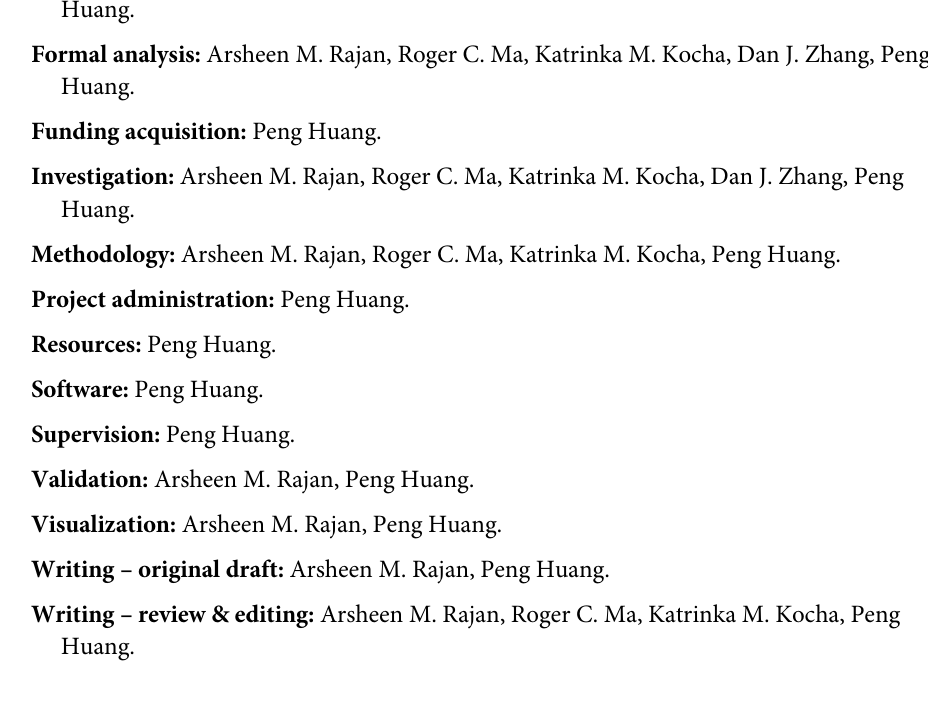
S3 Video. Perivascular fibroblasts function as pericyte progenitors. nkx3 . 1 NTR-mCherry ; pdgfrb : GFP embryos were imaged from 54 hpf to 76 hpf at 15 minute intervals with time stamps indicated in the hh:mm format. Two perivascular fibroblasts traced (arrows) can be seen gradually upregulating pdgfrb : GFP expression and extending pericyte-like cellular pro- cesses (notched arrowheads). Note that one of the traced cells (top arrows) migrated away from the ISV at 15:15. n = 16 embryos. Scale bar: 25 μ m. S1 Table. This table contains all the numerical data presented in this